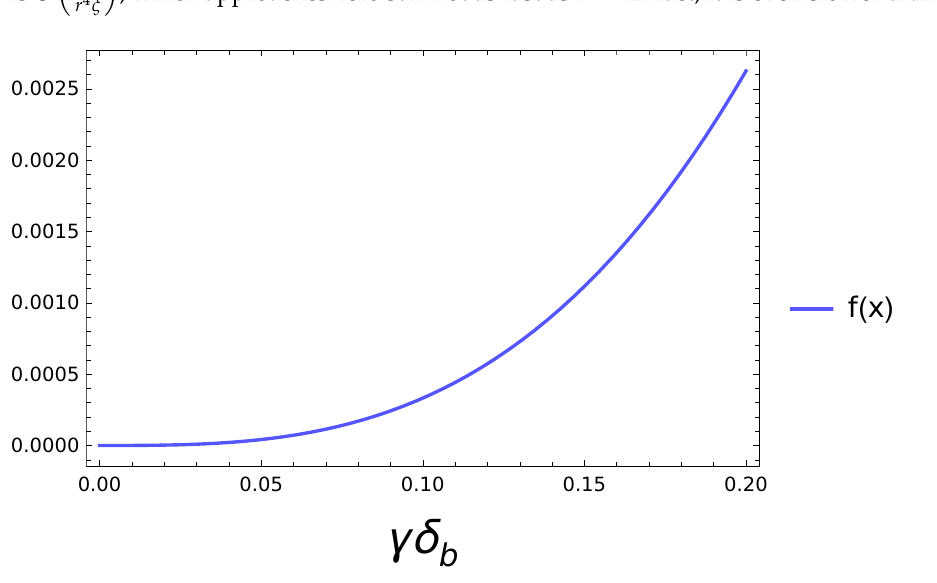
Figure 2. The function f ( x ) defined by Equation (68) vs. x ≡ γδ b